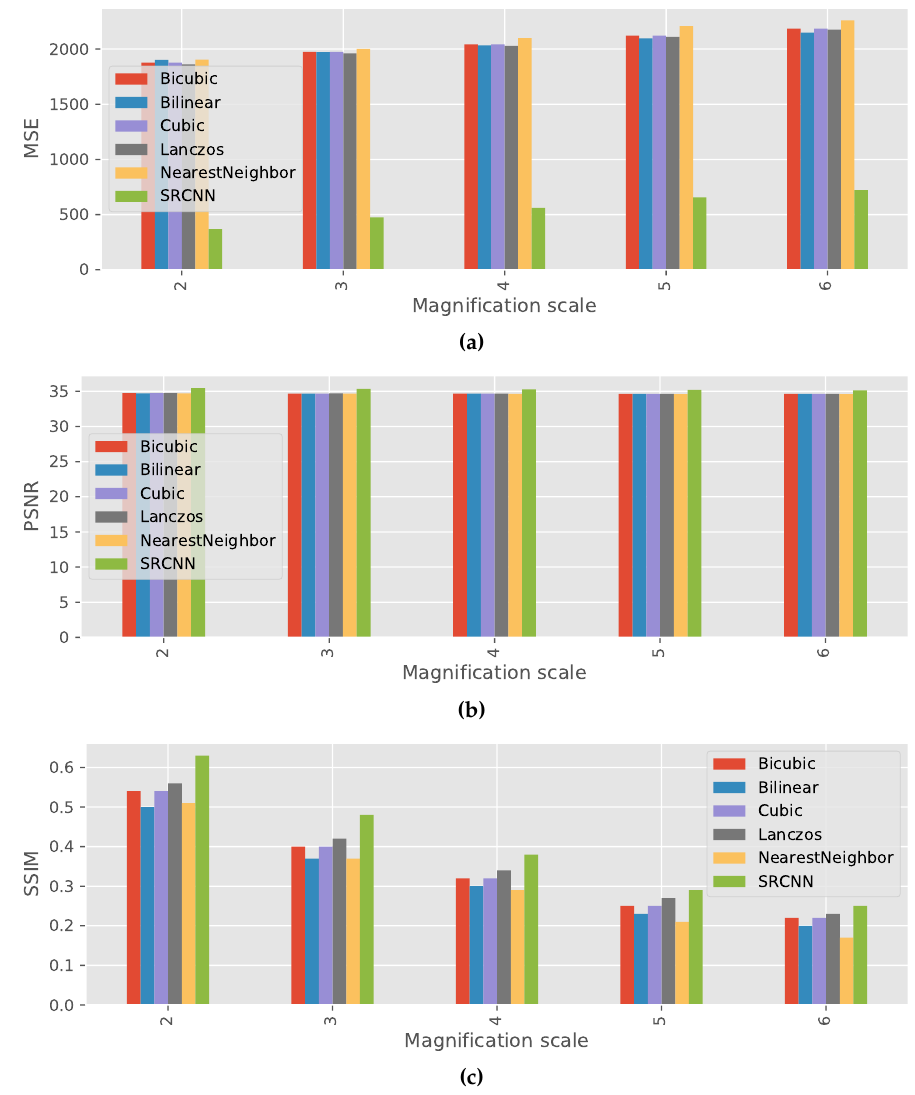
Figure 3. Comparison of average quantitative results produced by MSE, PSNR, and SSIM for different magnification scales. ( a ) MSE; ( b ) PSNR; ( c )